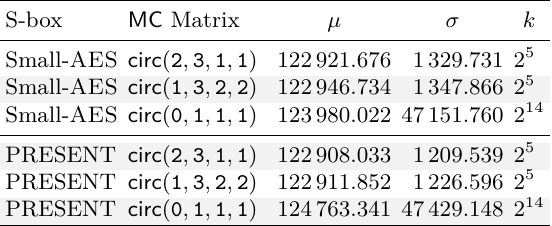
Table 6: Means, standard deviations, and maximal k for multiple-of- k for the number of collisions in at least one anti-diagonal after four rounds of 100 000 experiments with random key each of 2 16 texts from a full single-diagonal space. k is the maximum